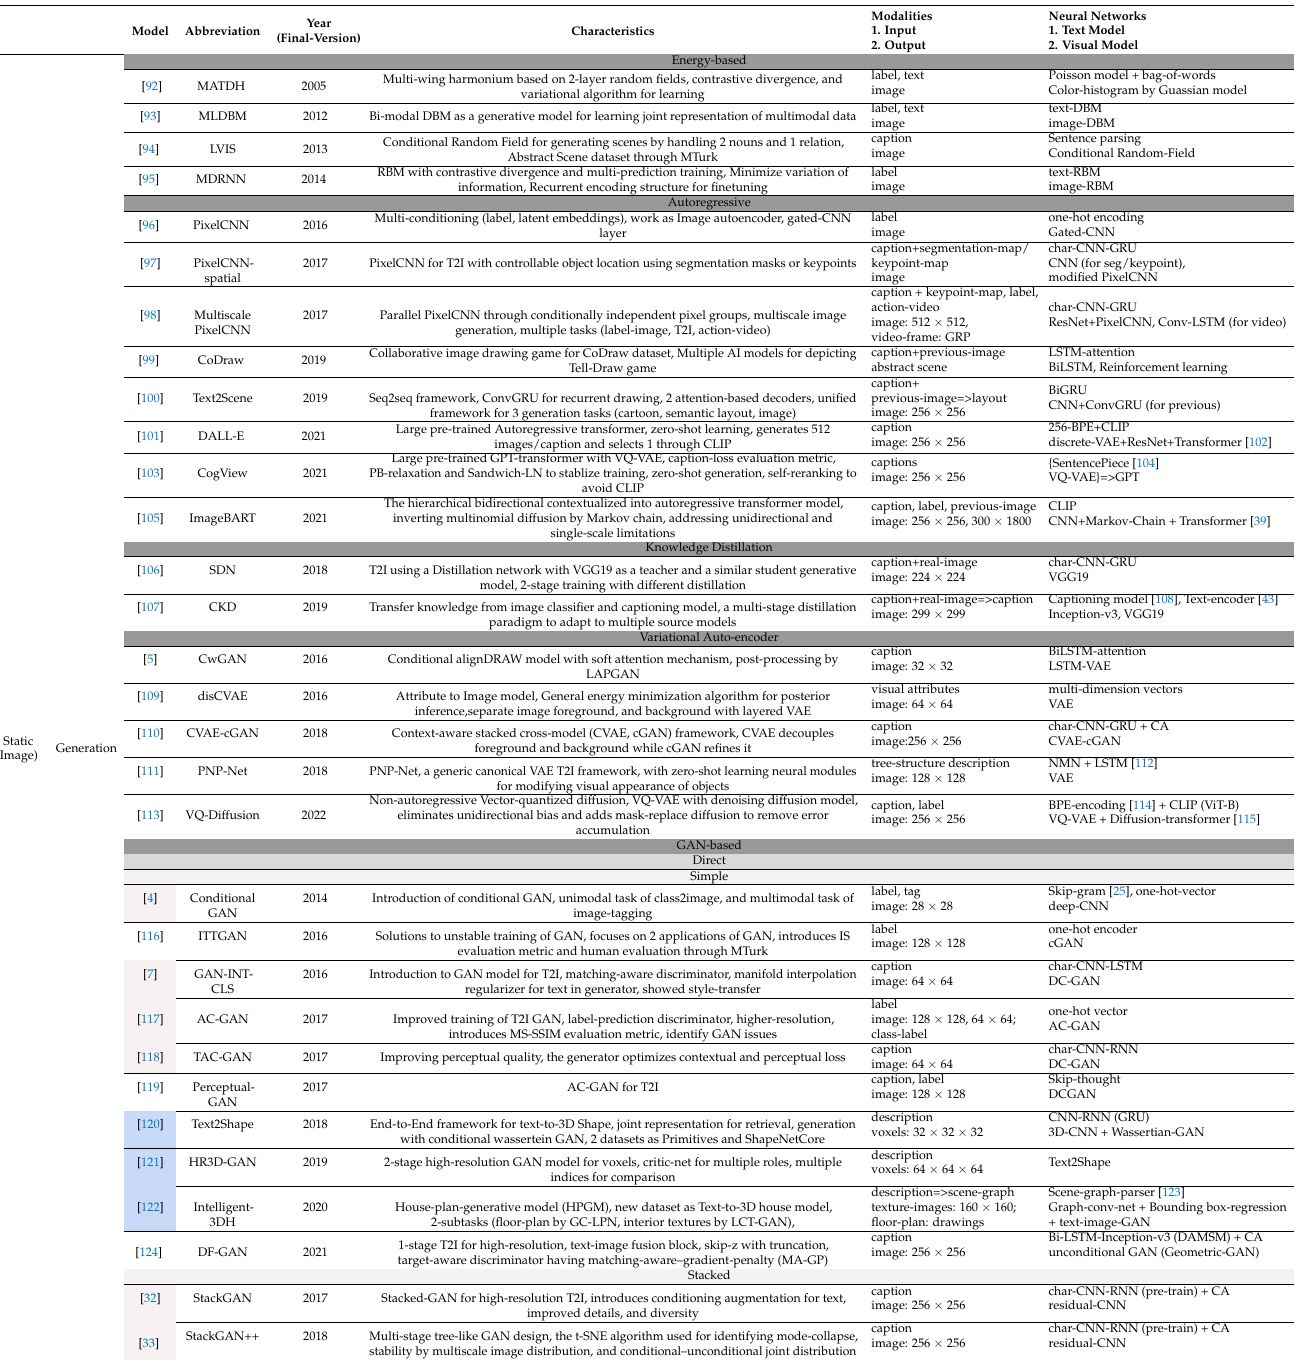
Table 2. Characteristics of the listed models. The references highlighted in red represent studies previously mentioned in [11], whereas those highlighted in blue are studies used for 3D visual output, as given in Figure